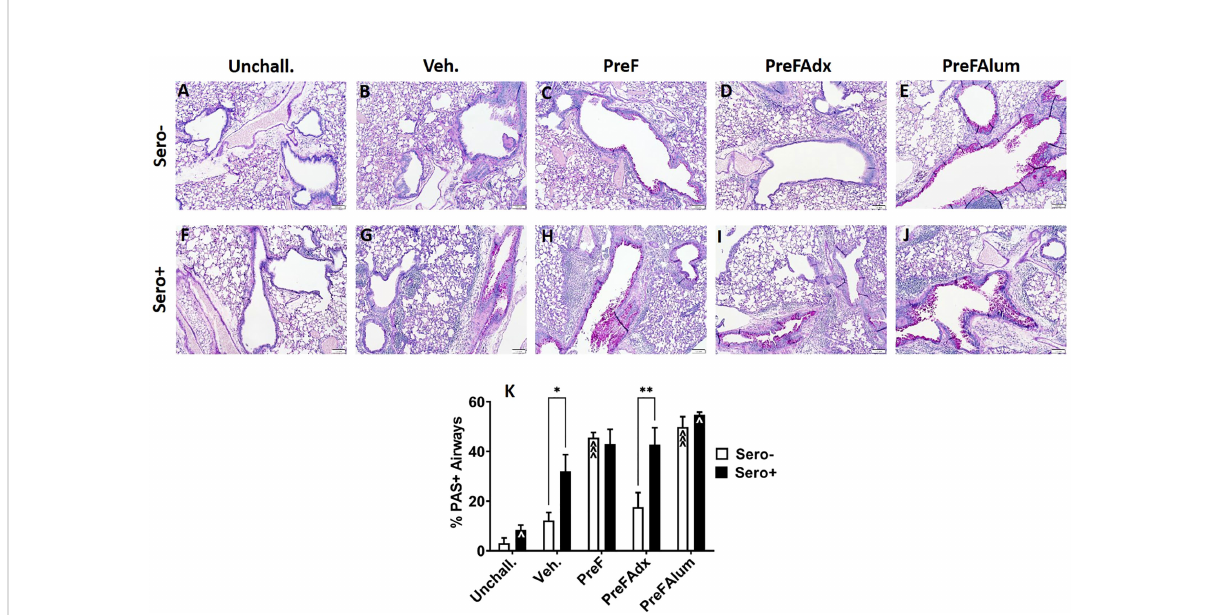
FIGURE 6 PAS staining is increased in sero- PreF- and PreFAlum-immunized mice and in sero+ mice independent of immunization regimen. Sero- and sero+ mice were immunized and challenged with virus as described in Figure 1. At 4dpi, sero- (A – E) and sero+ (F – J) lungs were formalin fi lled, paraf fi n embedded and sectioned for staining with PAS. Two independent, blinded investigators scored all slides as described in the methods. Scores between the two investigators were averaged and data represented as mean ± SEM ( n = 3-4 mice). Statistical signi fi cance was determined between sero- and sero+ groups within each immunization cohort using 2-way ANOVA with a Bonferroni post-test (K) ; *p<0.05 and **p<0.01. Comparisons to Veh. controls within the respective sero- and sero+ groups were made using an ANOVA with a Dunnett ’ s multiple comparison test; ^p<0.05 and